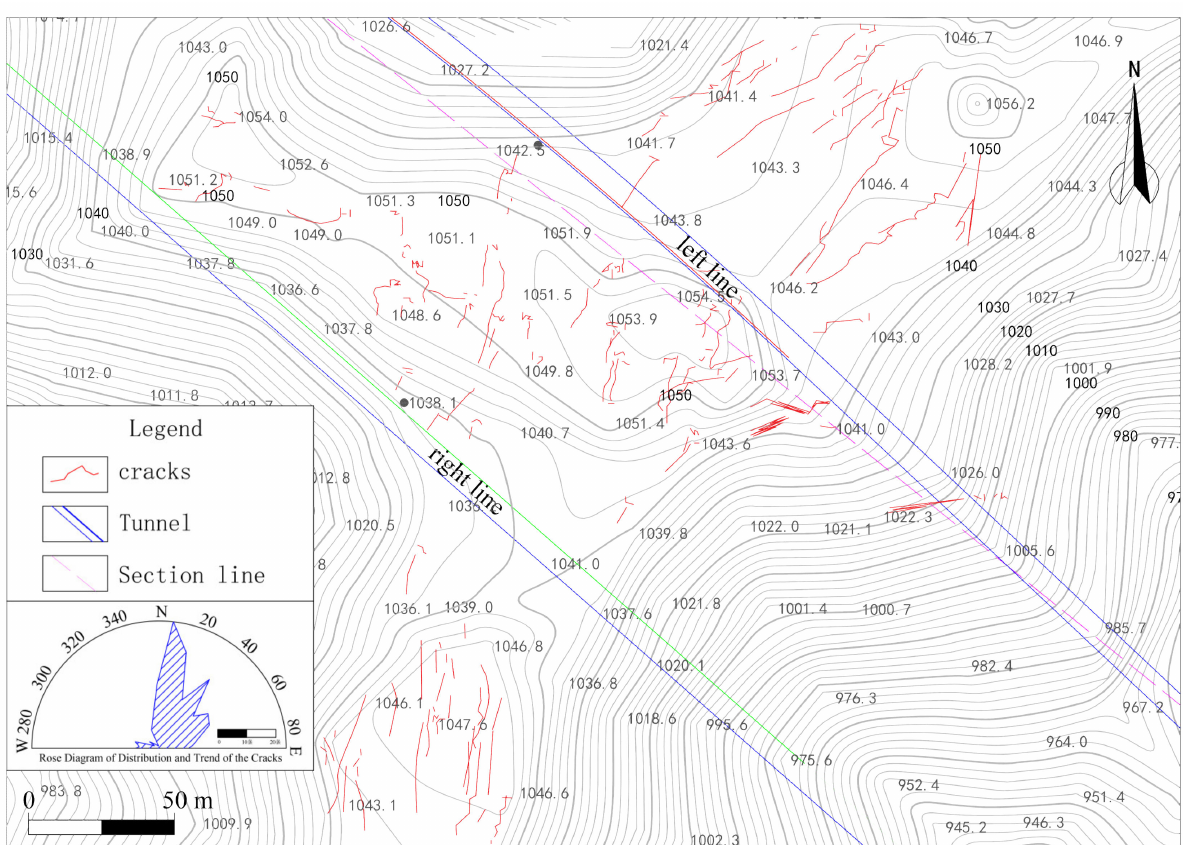
Figure 3. Distribution and strike rose diagram of cracks in the mountain of the Tianzimiao